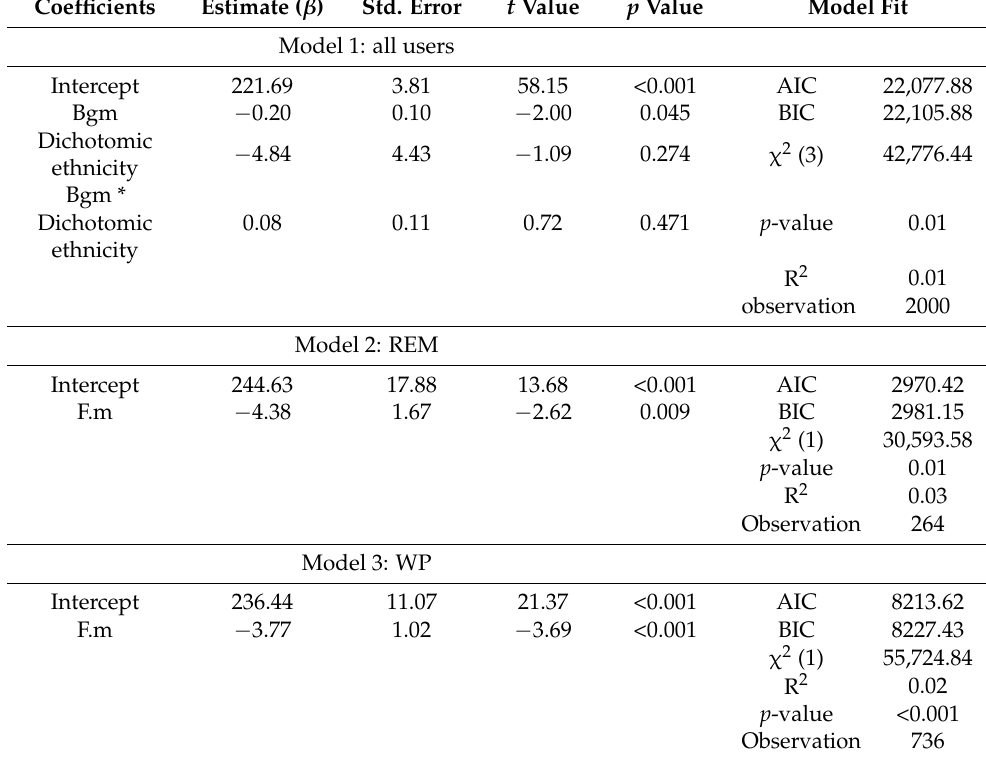
Table 3. General linear model results. Avg.bg presents the predictable variable—the average blood glucose levels; Bgm presents the number of measurements; WP, White persons; REM presents people from racial and ethnic minority groups; dichotomic ethnicity presents WP/REM. F.m presents frequency of measurements by